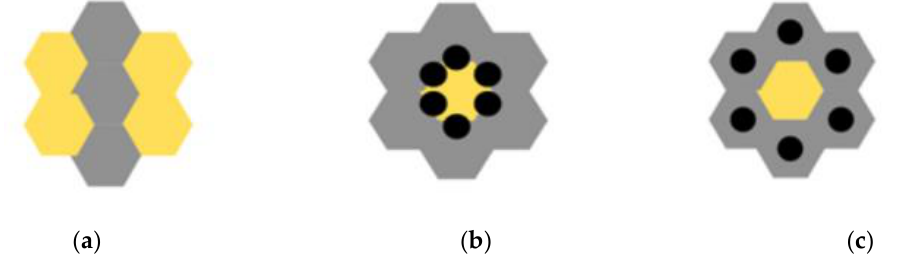
Figure 3. Definition of analysis metrics for T joint performance [25].